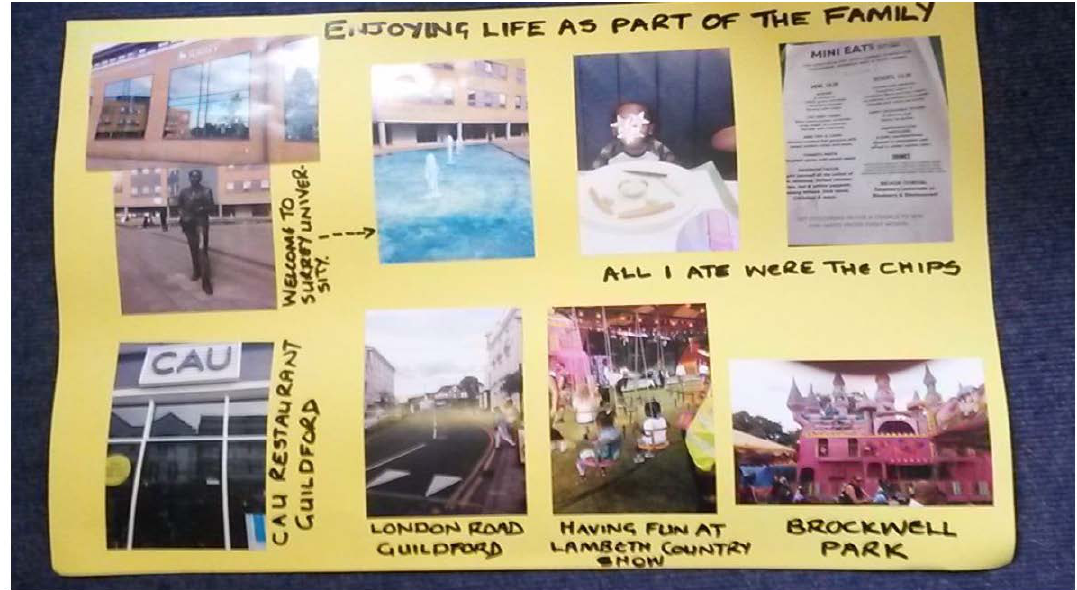
Figure 3. Enjoying life as part of the family (Meetoo et al.,